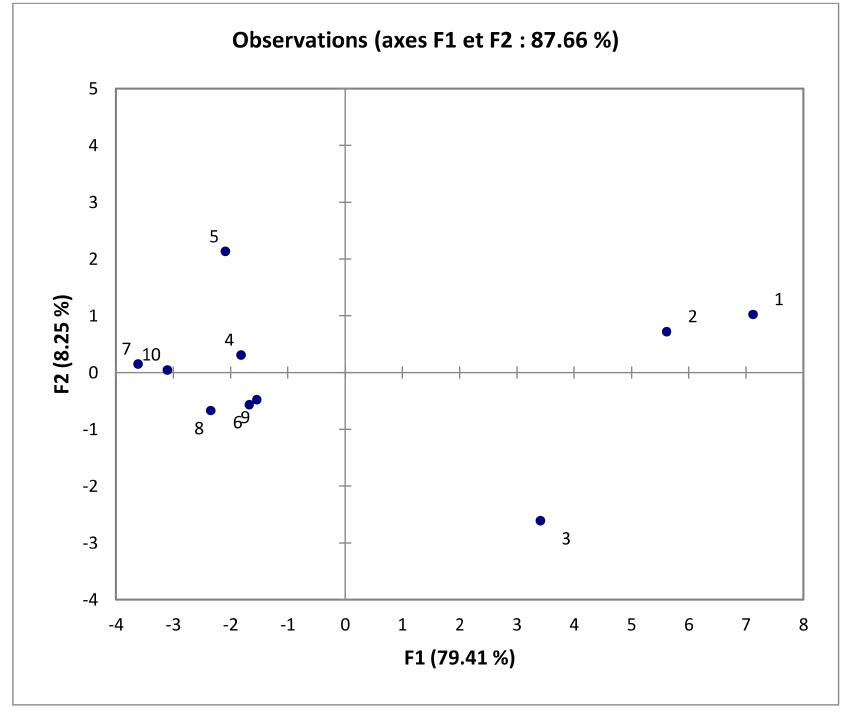
Figure 14. Principal component analysis for sampled water at the observation well T6: projection of individuals on the plane F1-F2 (campaigns 1 to